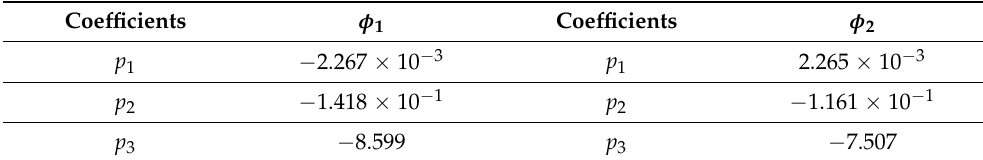
Table 5. Coefficients of approximating polynomials of the magnetic flux for first coil φ 1 and second coil φ 2